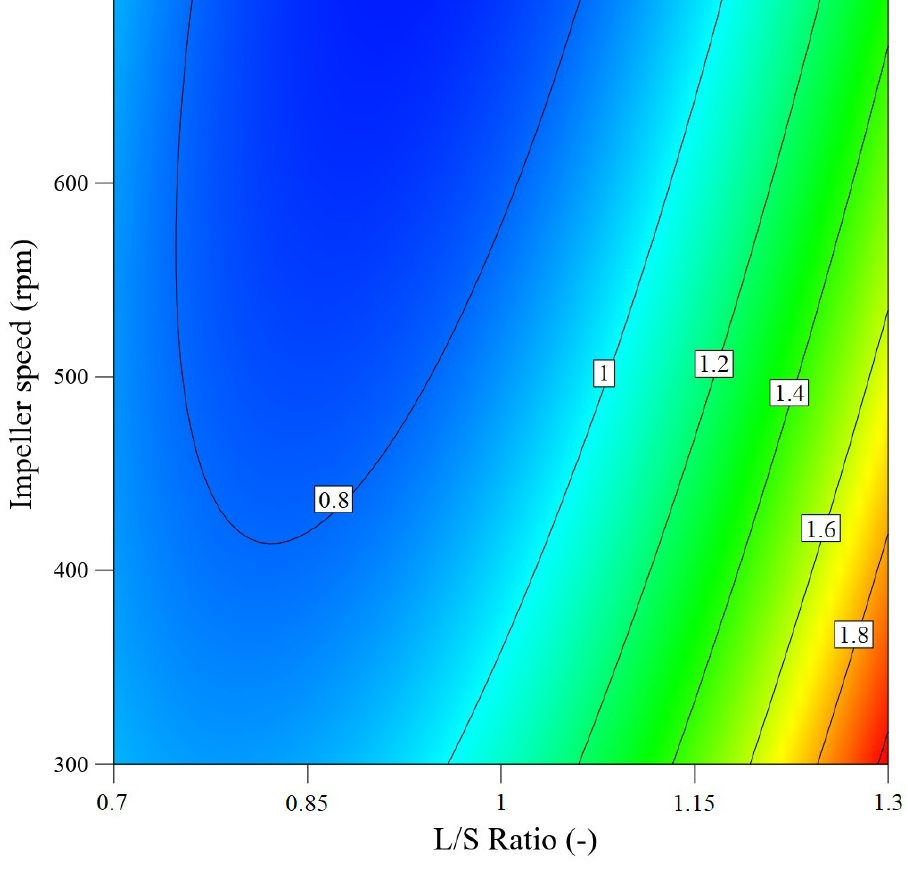
Figure 13. Contour plot of quadratic model for prediction of mean granule size as function of L/S ratio and impeller speed.